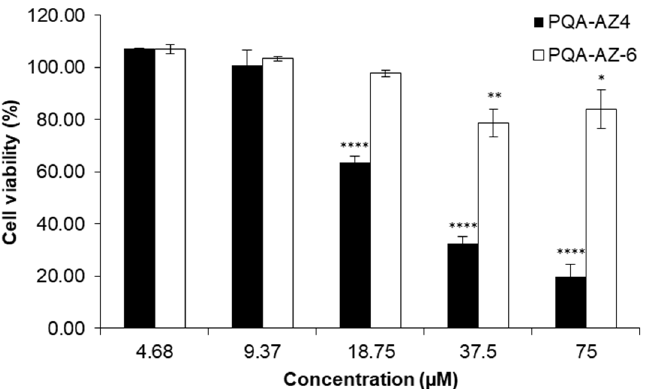
Figure 9. Cytotoxic effects of PQA-AZ4 and PQA-AZ6 on NHDF cells, determined by the MTT assay after 48 h of incubation. Data represent the mean ± SEM. Statistical significance was estimated using one-way ANOVA with the post hoc Dunnett’s test for multiple comparisons and presented as * p ≤ 0.05, ** p ≤ 0.01, and **** p ≤ 0.0001.